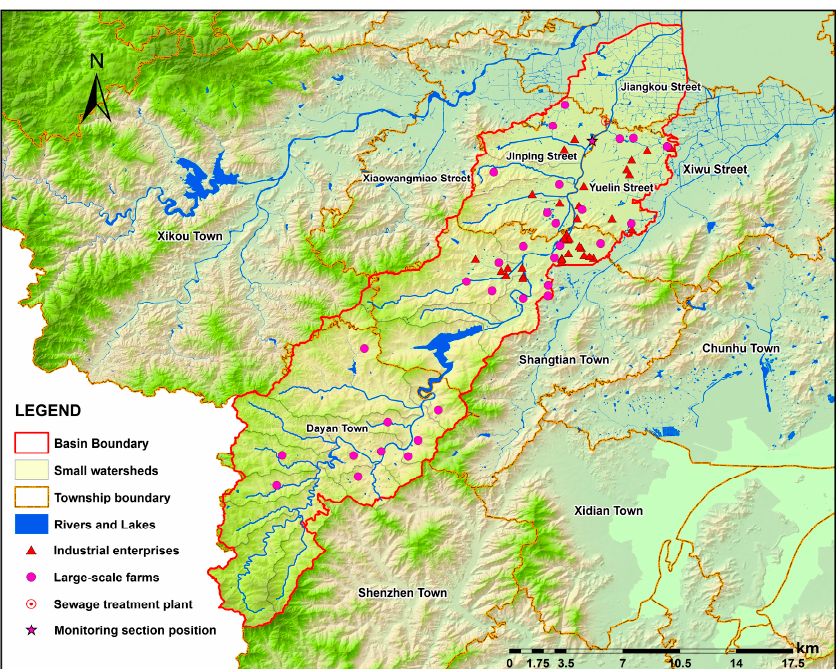
Figure 1. The geographic distribution of rivers and pollution sources situates in Xian-Jiang Basin.